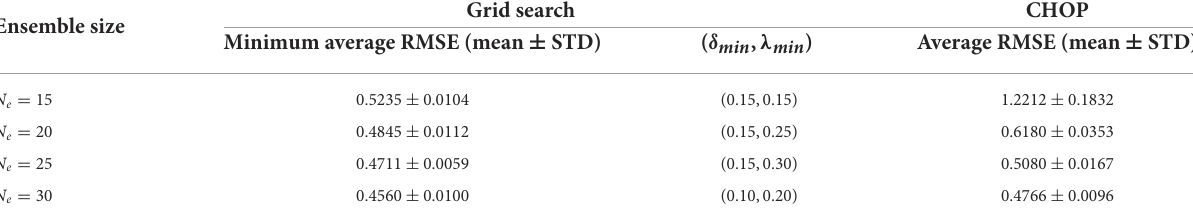
TABLE 1 Performance comparison between the grid search method and the CHOP workflow applied to the reference algorithm (Equation 30) in the full observation scenario, with four different ensemble sizes. Grid search CHOP Ensemble size Minimum average RMSE (mean ±